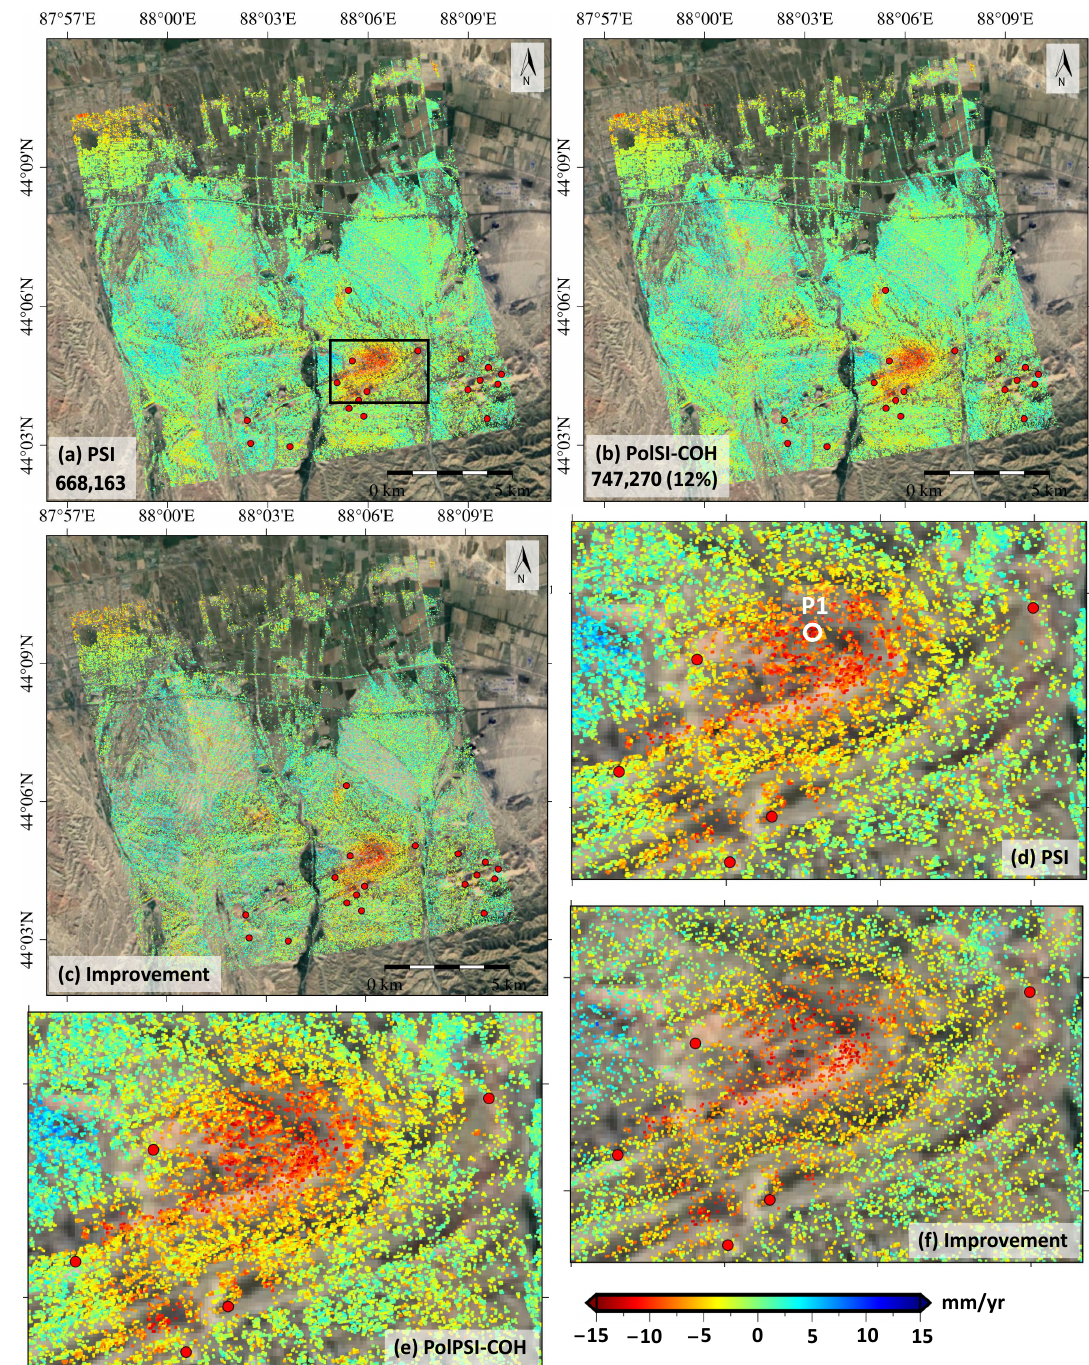
Figure 11. ( a , b ) shows the deformation velocity (in the line-of-sight direction) derived by the PSI (VV) and PSI-COH (VV+VH) approach, respectively. The number represents the final number of selected pixels for each approach, and the improvement percentage in the brackets in ( b ) is with respect to those derived by the PSI approach. ( c ) is the additional pixels (i.e., the pixel density improvement) achieved by PolPSI-COH with respect to that of PSI. ( d , e ) shows the detailed ground deformation obtained by PSI and PolPSI-COH over the Laobata coal fire area (black rectangle in ( a ) highlighted), respectively. ( f ) is the additional pixels (i.e., the pixel density improvement) achieved by PolPSI-COH with respect to that of PSI over the Laobata coal fire area. The red dots indicate the locations of filed survey detected coal fire points, and the white circle in ( d ) highlights the location of the selected pixels for deformation time-series analysis in Figure